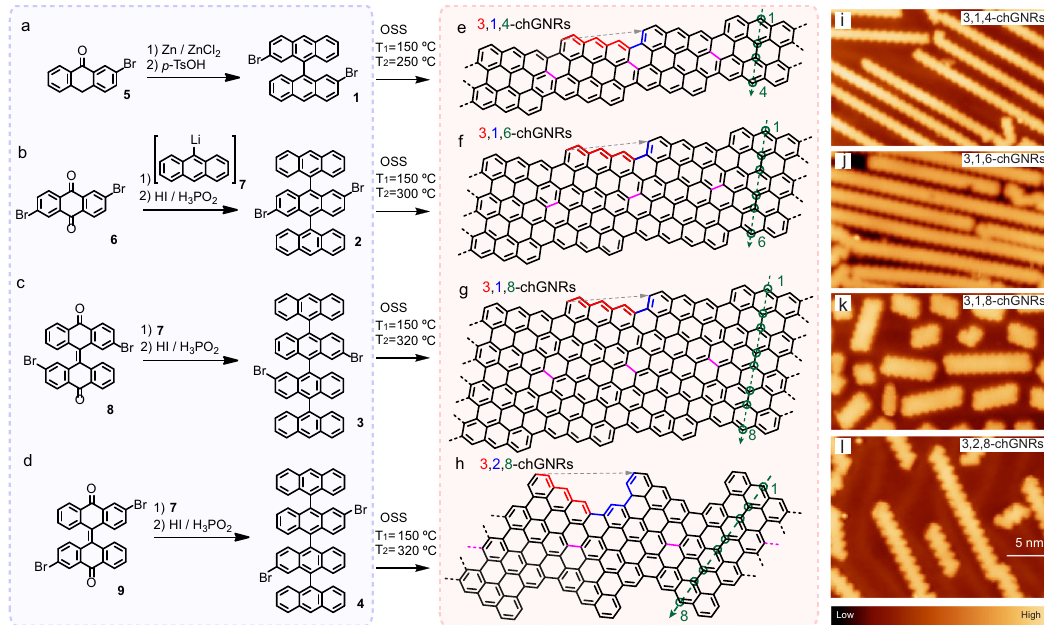
Fig. 2 Synthetic strategy to produce chGNRs combining solution and on-surface synthesis. a – d solution synthesis protocols for producing molecular precursors 1 , 2 , 3 , for the synthesis of 3,1, w -chGNRs with different widths ( w = 4, 6 and 8), and precursor 4 for 3,2,8-chGNRs. Synthesis details are described in the text and in the Supplementary Methods. e – h targeted chemical structures of chGNRs by using the four molecular precursors in a – d , respectively. Green circles highlight the carbon atoms across the GNRs, which measure the width of the GNRs. The GNRs are named following the sequence of z zigzag sites, a brominated site (see Supplementary Note 1), and w width, as z , a , w -chGNRs. Red(blue) bonds highlight the zigzag(armchair) segments of the chGNRs. Bonds in purple indicate the pathway for Ullmann coupling. i – l STM overview images of the chGNRs formed on a Au(111) surface after stepwise annealing the sample covered with precursors 1 – 4 to temperature T 1 (10 min) and then to temperature T 2 for Ullmann coupling and CDH, respectively. (sample bias V s = 1 V, scale bar as labeled in l